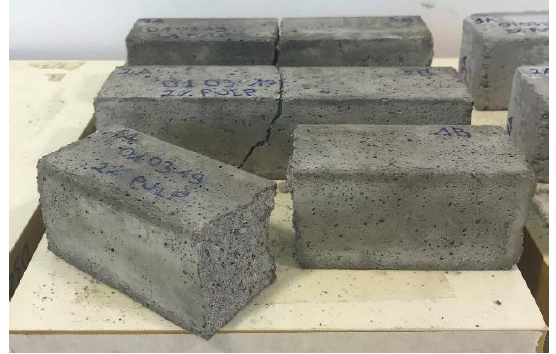
Figure 3. Pulp specimens after the flexural failure. Table 2. Average strengths of tested triplets.